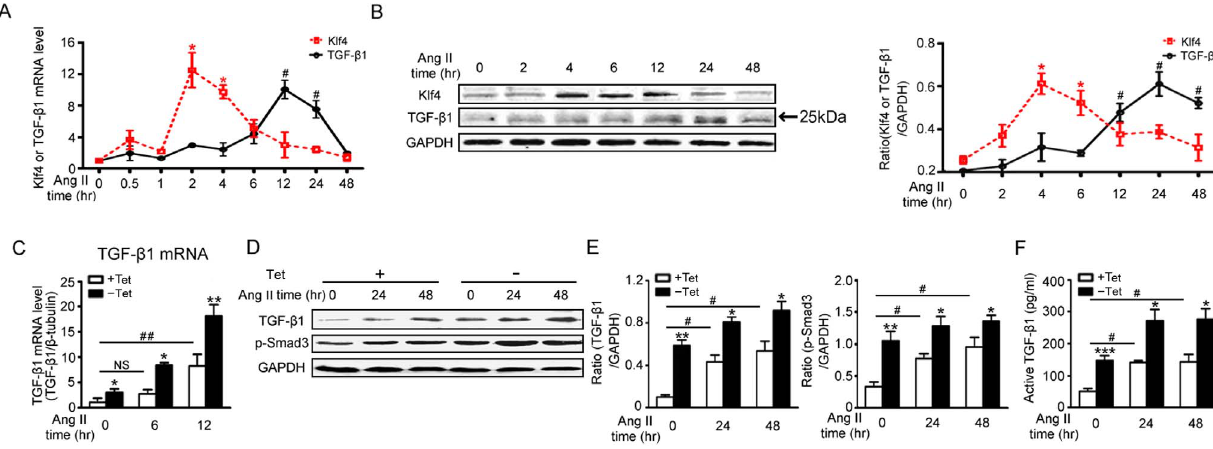
Figure 4. Klf4 controls Ang II-induced TGF- b 1 production. A, Klf4 and TGF- b 1 mRNA levels were assessed by qPCR in Ang II-treated cardiac fibroblasts and were normalized to b -tubulin (n=3). B, Klf4 and TGF- b 1 protein levels were assessed by Western blot in Ang II-treated cardiac fibroblasts. GAPDH was the loading control (n=3). Data are the mean 6 SEM. *P , 0.05, **P , 0.01 vs. Ang II treatment for 0 hr. C-F, cardiac fibroblasts were co-infected with Ad-tTA and Ad-Klf4 and treated with Ang II. C, TGF- b 1 mRNA levels were assessed by qPCR after Ang II treatment for 0, 6 or 12 hrs and normalized to b -tubulin (n=4). D, TGF- b 1 and phosphorylated Smad3 (p-Smad3) protein levels were assessed by Western blot after Ang II treatment for 0, 24 or 48 hrs. E, level of quantification of TGF- b 1 and p-SMAD3 as a ratio of GAPDH in densitometric units was presented. n=4. F, ELISA was used to analyze active TGF- b 1 levels in the supernatant after Ang II treatment for 0, 24 or 48 hrs (n=5). Data are the mean 6 SEM. *P , 0.05, **P , 0.01 vs. control. # P , 0.05, ## P , 0.01 vs. control and Ang II treatment for 0